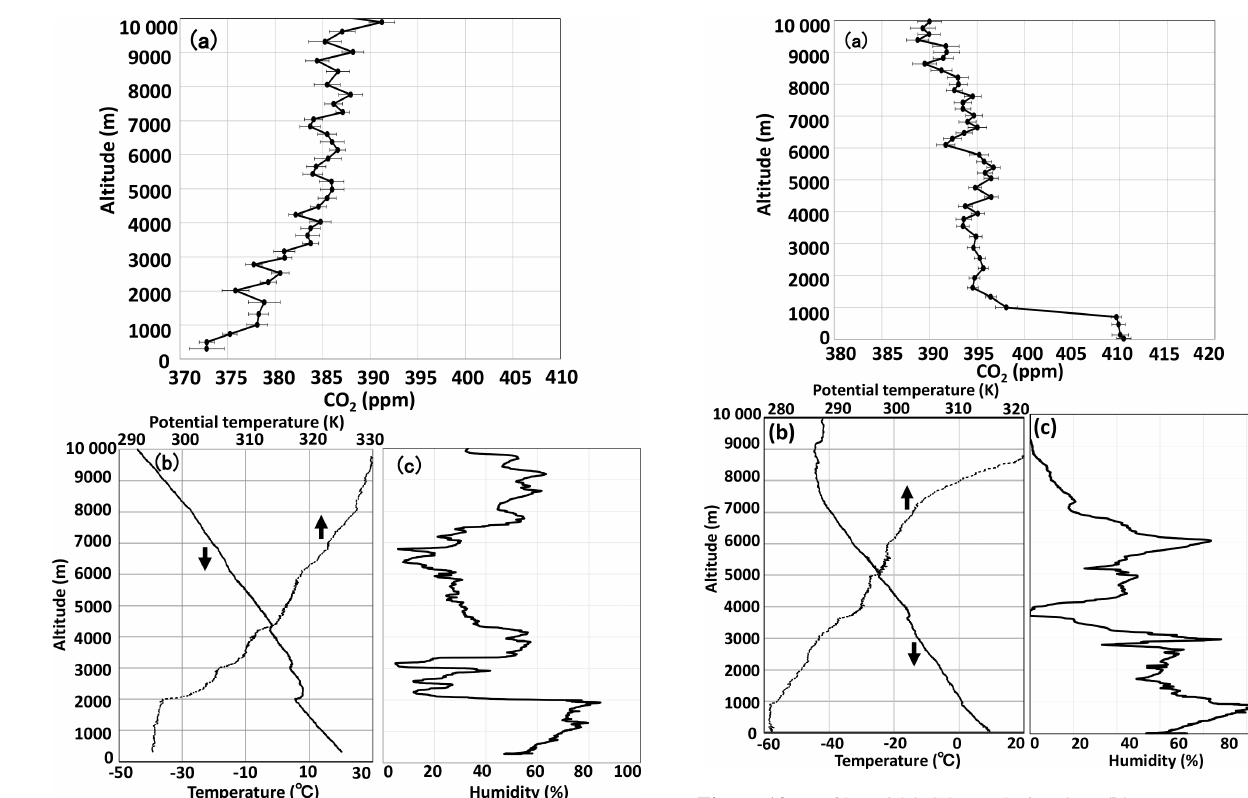
Figure 10. Profiles of (a) CO 2 mole fraction, (b) temperature (solid line) and potential temperature (dotted line), and (c) relative humid- ity observed over an urban area, Moriya near Tokyo, on 3 Febru- ary 2011 at